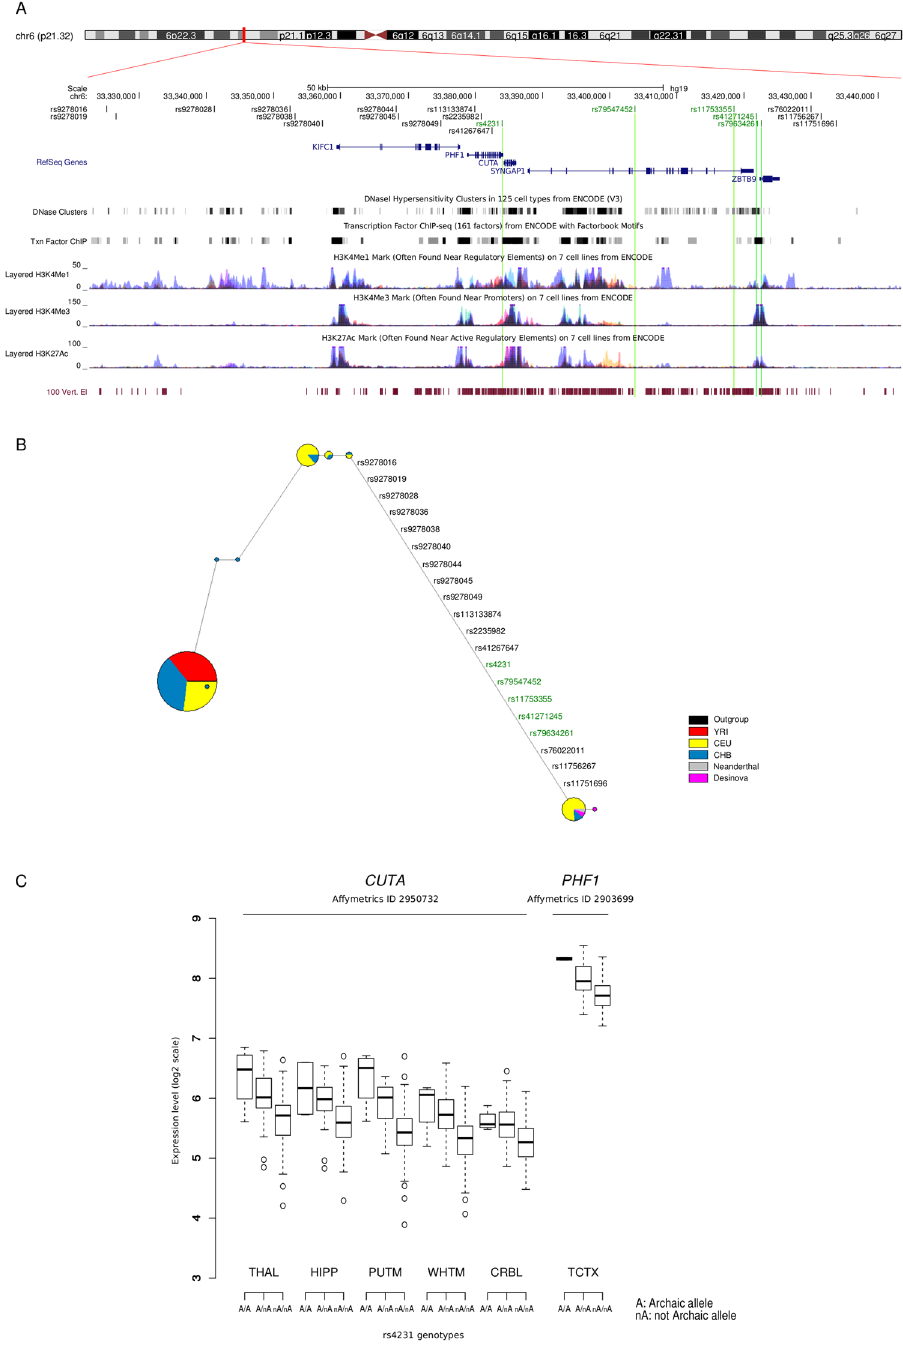
Figure 6. Neanderthal introgression at the SYNGAP1 locus. ( A ) The genomic region containing SYNGAP1 is shown within the UCSC Genome Browser view. The 20 archaic variants defining the introgressed Neanderthal haplotype are reported. Relevant annotation tracks are also shown. SNPs reported as eQTLs in BRAINEAC are in green. ( B ) Haplotype analysis reconstructed through a median-joining network of SYNGAP1 introgressed SNPs. Each node represents a different haplotype, with the size of the circle proportional to frequency. IDs for SNPs defining the haplotype shared by Neanderthals, Denisovans, and a small fraction of non African modern humans are listed on the branch. ( C ) Box plot representation of CUTA and PHF1 genes expression levels stratified by genotype status at rs4231. Data derive from the BRAINEAC data collection (THAL, thalamus; HIPP, hippocampus; PUTM, putamen; WHMT, white matter; CRBL, cerebellum; TCTX, temporal